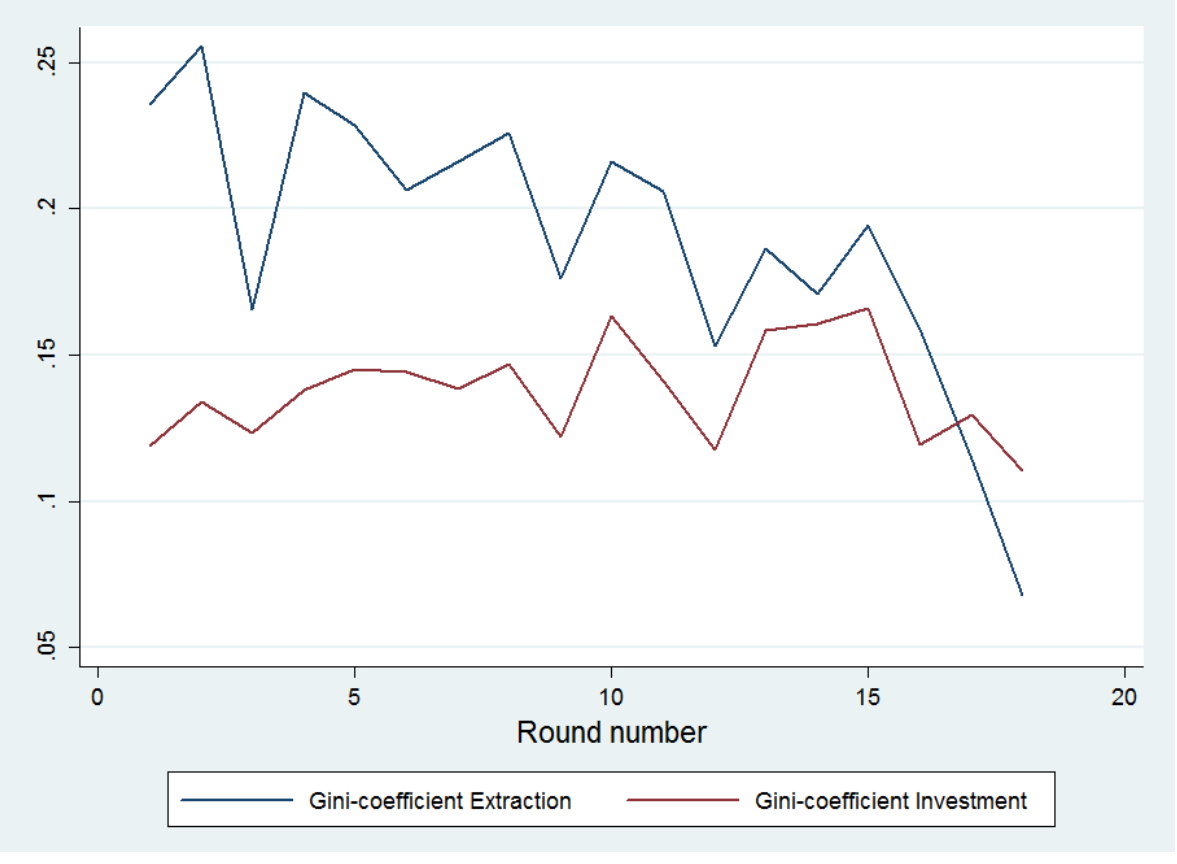
Figure A5.1. Average group Gini-coefficient for investment and extraction over experiment